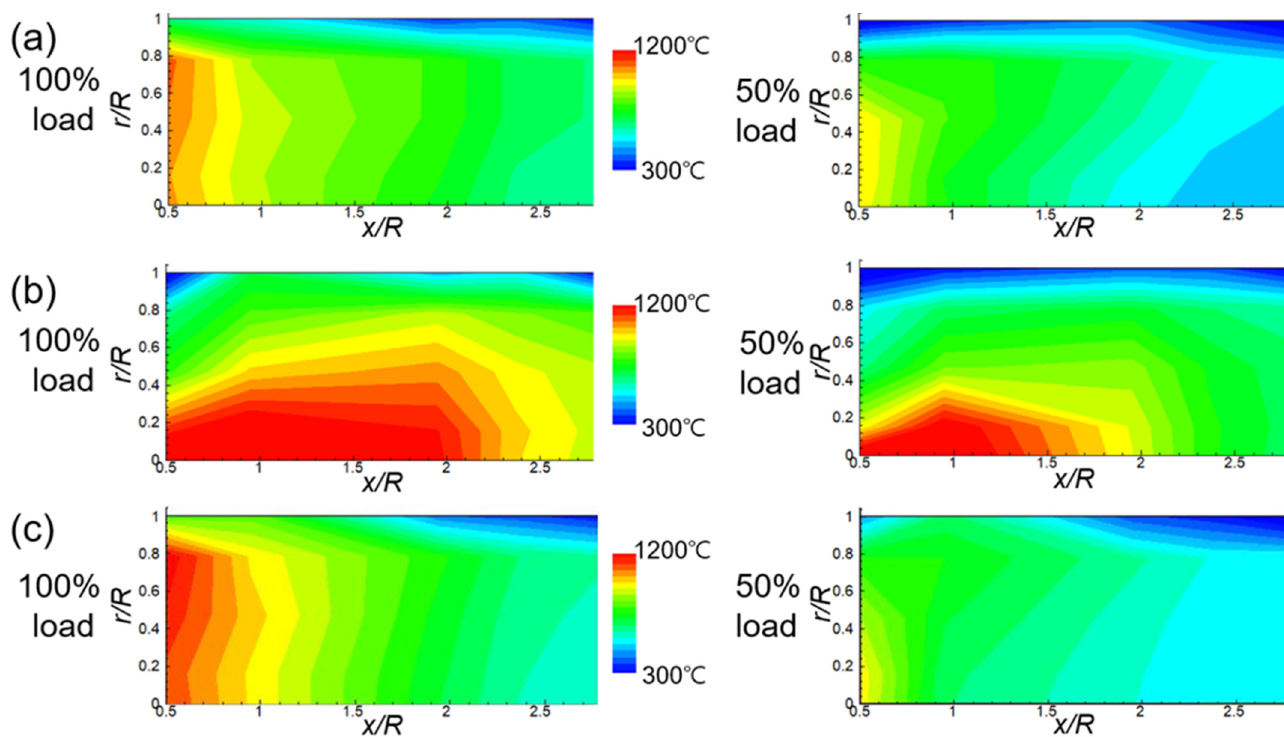
Figure 7. Temperature distribution inside the combustion chamber for ( a ) air combustion, ( b ) oxy-fuel combustion, and ( c ) oxy-fuel FGR combustion.